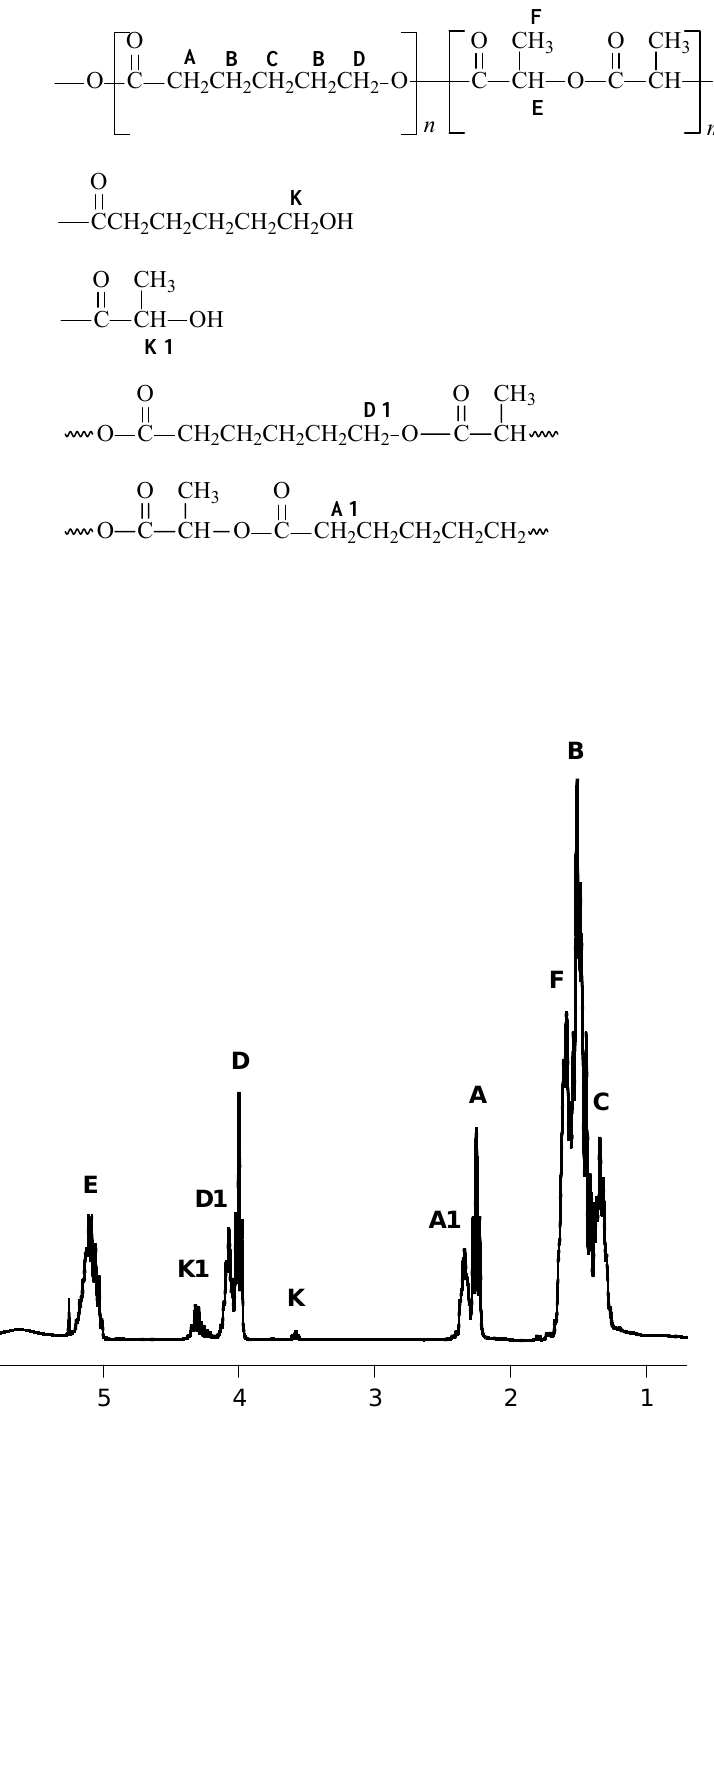
Figure 2. 1 H-NMR spectra of the CL/LA copolymer produced in the presence of carnitine and SnOct 2